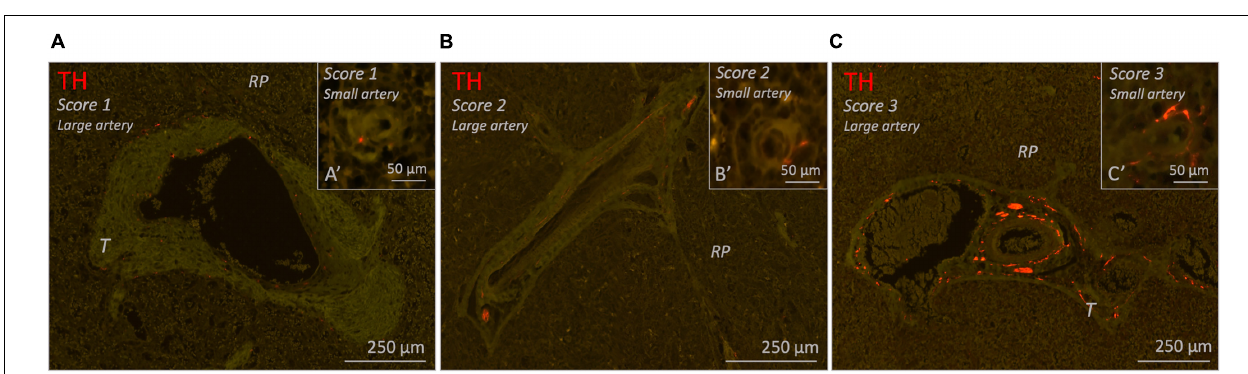
FIGURE 6 | Fluorescence microscopic images of various of blood vessel related sympathetic nerve densities (TH staining) in different 25–70 years age group individuals. Each figure contains a representative example of a large vessel and a small vessel with a specific amount of sympathetic nerves (score 1–3). (A–C) Splenic samples with a low, moderate or high density of sympathetic nerves surrounding large arteries (score 1-3). (A’–C’) Splenic samples with a low, moderate, or high density of sympathetic nerves surrounding small arteries (score 1–3). RP, red pulp; T,